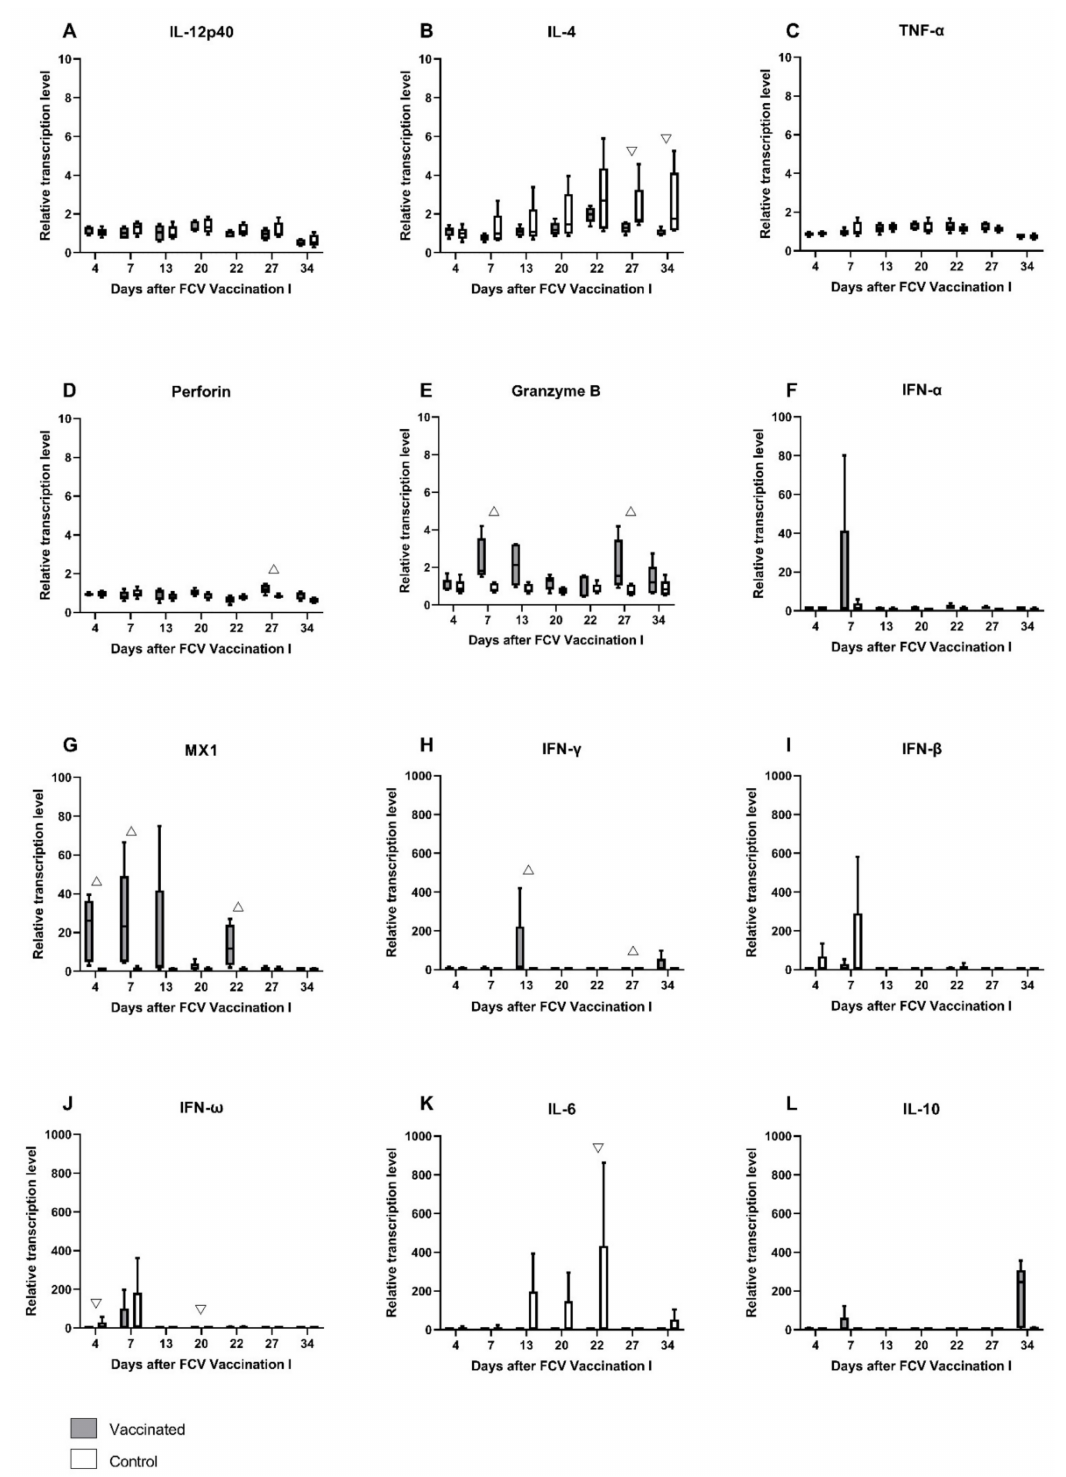
Figure 3. Box and whisker plots of cytokine expression profile of IL-12p40 ( A ), IL-4 ( B ), TNF- α ( C ), perforin ( D ), granzyme B ( E ), IFN- α ( F ), MX1 ( G ), IFN- γ ( H ), IFN- β ( I ), IFN- ω ( J ), IL-6 ( K ) and IL-10 ( L ) after FCV Vaccination I. The line inside the box shows the median, and the lower and upper border of the box indicates the 25th and 75th percentile, respectively. Whiskers represent minimum and maximum values. Significant differences between the vaccinated and the control group are indicated with an open triangle; (cid:53) denotes significantly lower in the vaccinated group P MWU ≤ 0.05; (cid:52) denotes significantly higher in the vaccinated group P MWU ≤ 0.05. The second injection of FCV Vaccination I was performed at day 21. The y-axes are scaled either at 0–10, 0–100, or 0–1000 relative mRNA transcription level, and the graphs are ordered